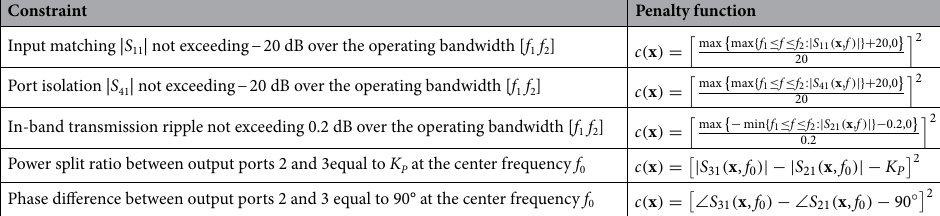
Table 2. Possible formulation of penalty functions for constraints of Table